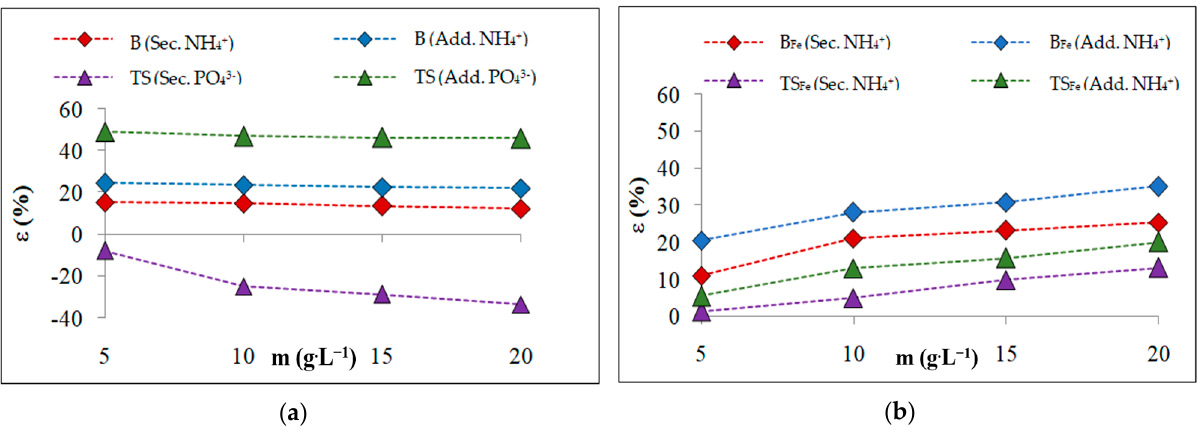
Figure 4. Changes in sorption efficiency for selective and additional sorptions: ( a ) B, TS; ( b ) B Fe , TS Fe . During the additional adsorption, the sorption efficiency increased from 6% for ad- sorption NH 4+ on PO 43 − —TS Fe system (Figure 4b) to 60% for adsorption of PO 43 −